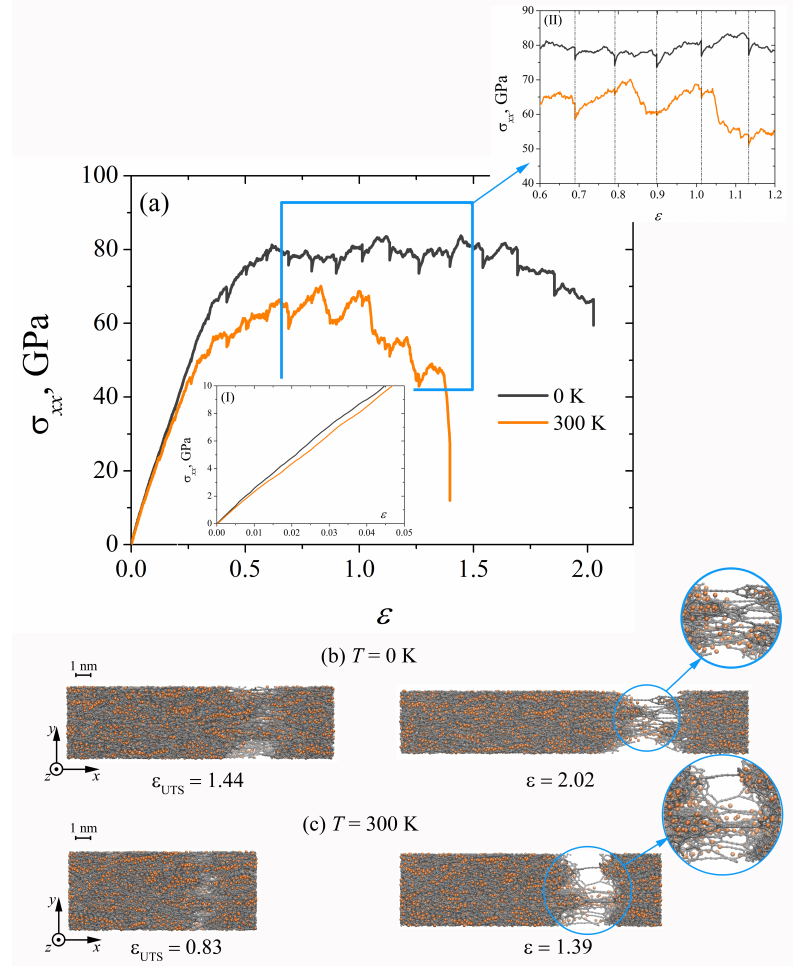
Figure 6. ( a ) Stress–strain curves during uniaxial incremental tension at ˙ ε = 5 × 10 − 3 ps − 1 for two temperatures: 0 K and 300 K. Inset (I) shows the elastic regime and inset (II) shows the difference of the σ xx at 0.6 < ε < 1.2. The dashed-dotted lines in inset (II) corresponds with the “relaxation” stages between uniaxial tension stages. ( b , c ) The snapshots of Ni/graphene composite at 0 and 300 K, respectively. Colors as in Figure